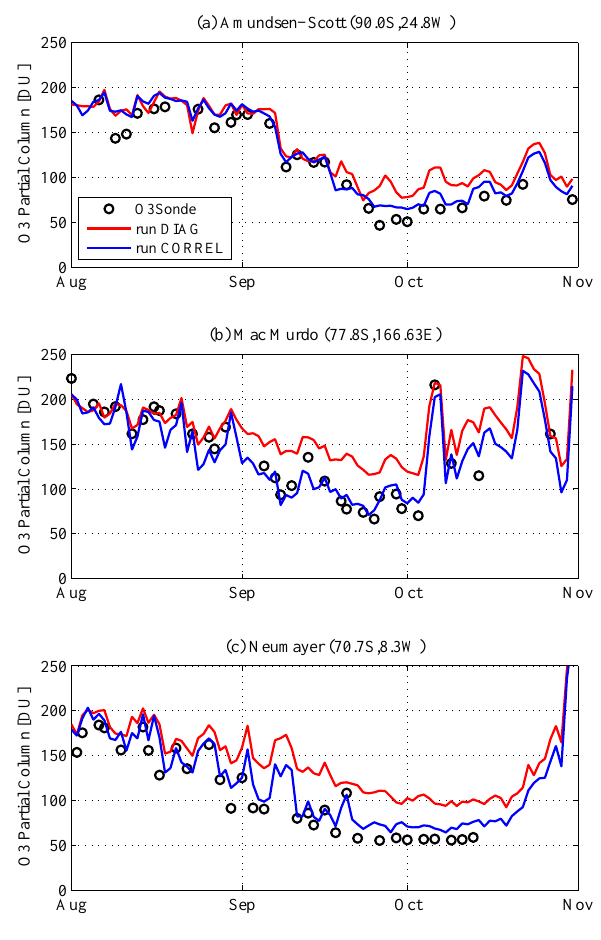
Fig. 5. Time series of the ozone partial column (10–100hPa) be- tween August and October 2003 obtained above three NDACC sta- tions in Antarctica by the ozone sondes (black circles), and the runs DIAG (red line) and CORREL (blue line), in Dobson unit (DU).